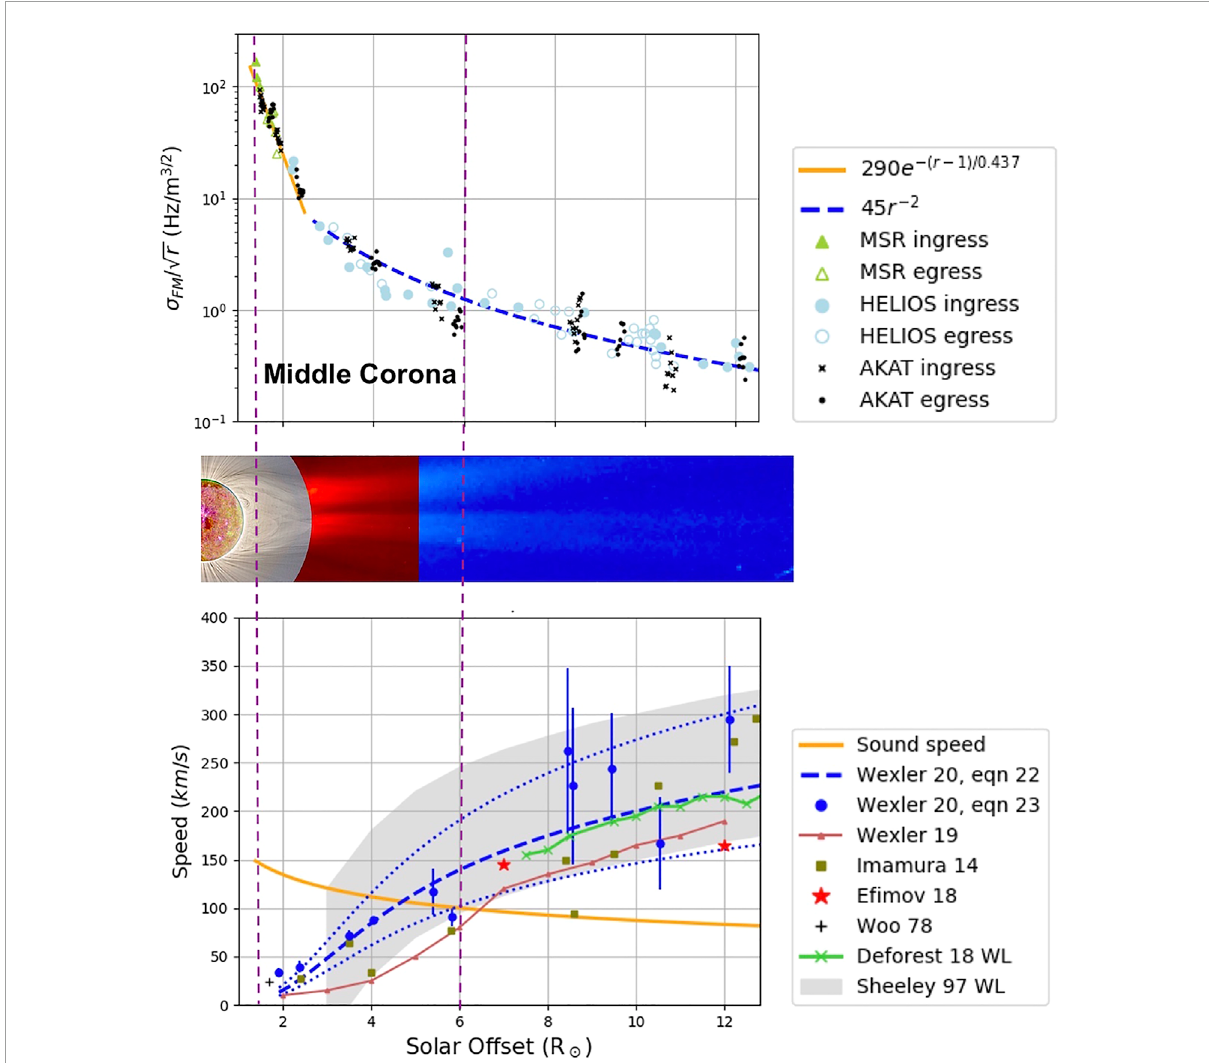
FIGURE 1 Transcoronal radio frequency fluctuation results, based on Wexler et al. (2020). Upper Panel. σ FM /√ r with dual regimes of subsonic fit (orange line) and acceleration zone fit (blue dashed line). Middle Panel. Composite imaging through the corona. From left to right Composite EUV of solar surface (NOAA SUVI, courtesy of Daniel B. Seaton.), Eclipse image of low-to-middle corona (courtesy of Jay M. Pasachoff, Williams College Eclipse Expedition/NSF), middle corona in white light (SOHO/LASCO C2), outer corona in white light (SOHO/LASCO C3 imager). Lower Panel. Solar wind speed profile, composite of several studies (references in text). The solar wind approaches or exceeds supersonic speeds as reaching the middle corona upper boundary at 6 R ⊙